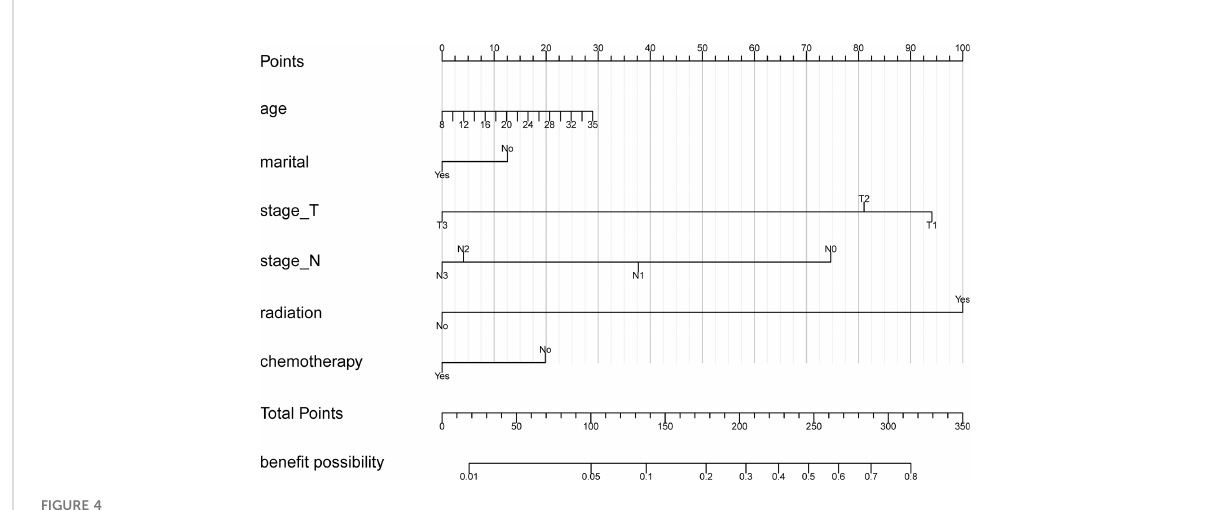
FIGURE 4 The nomogram to predict the bene fi t from breast conserving surgery (BCS).